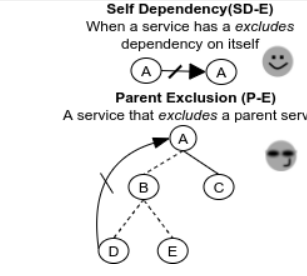
Figure 10. Validation scenarios involving excludes